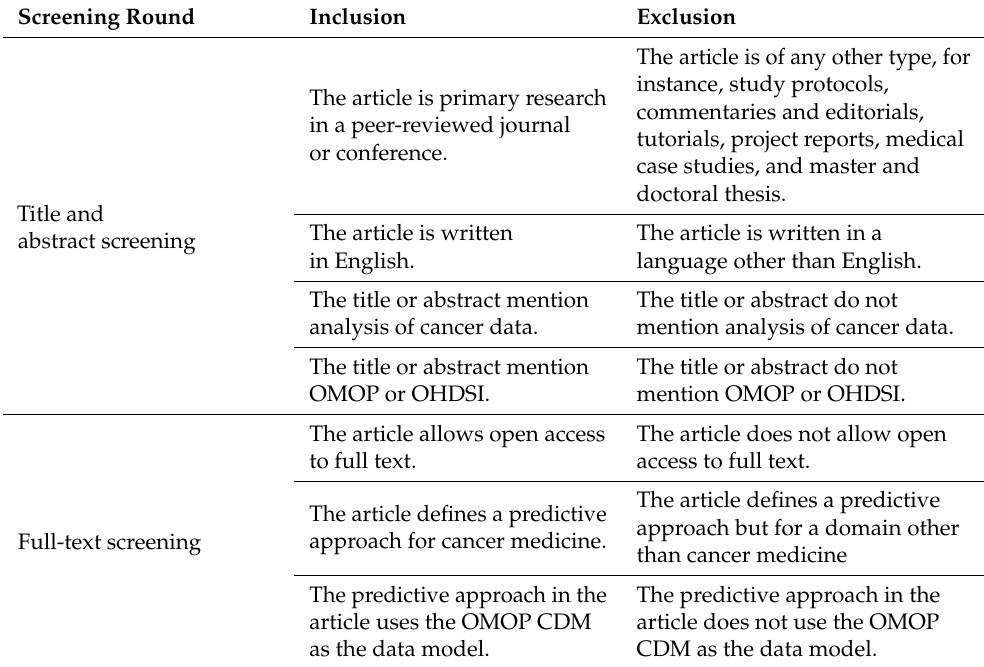
Table 2. Inclusion and exclusion criteria for the title and abstract screening and full-text